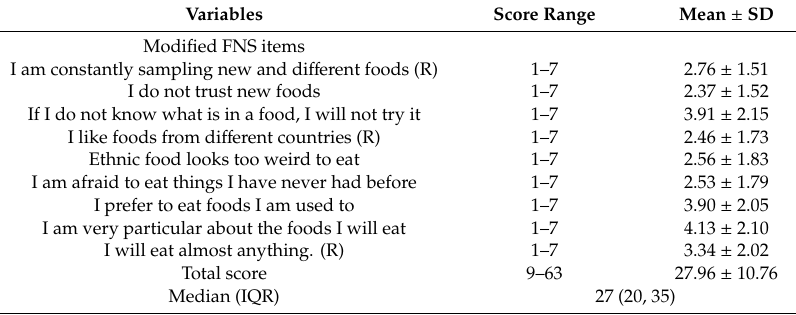
Table A1. Assessment of maternal food neophobia ( n =